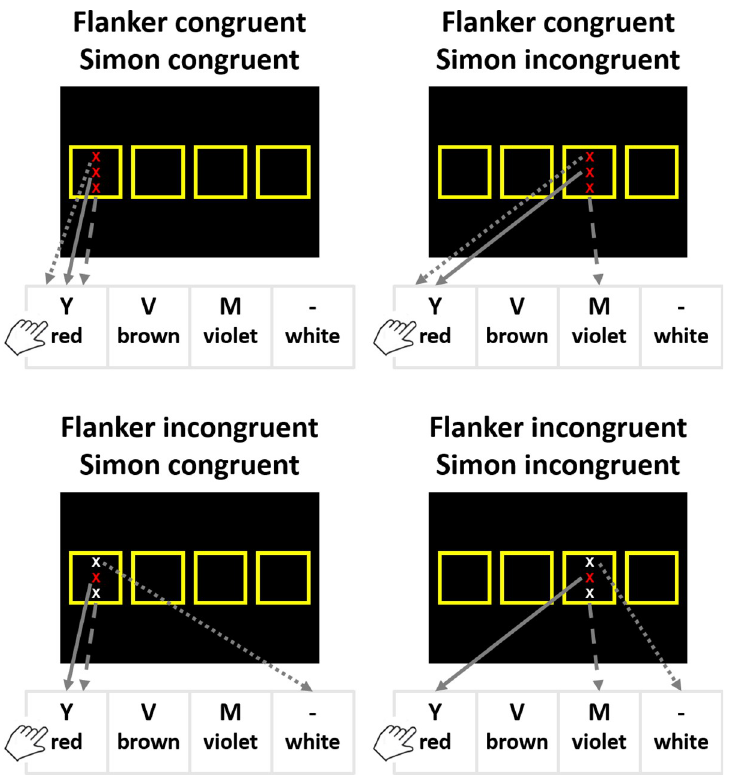
Fig 3. Schematic depiction of the design used in Experiment 1 in which Simon and flanker irrelevant features were conveyed by different objects for all trial types (flanker congruent–Simon congruent, flanker congruent– Simon incongruent, flanker incongruent–Simon congruent, flanker incongruent–Simon incongruent). The target feature associated to the correct response is the color of the central X, which was presented either in red, brown, violet, or white. X’s presented above and below the central X were the flanker stimuli. Solid arrows represent the priming of the target feature (i.e., the color of the central X) to the correct response. Dotted arrows represent the priming of the flanker irrelevant feature (i.e., the color of the flanker X) to the response. Dashed arrows represent the priming of the Simon irrelevant feature (i.e., the location of the screen) to the